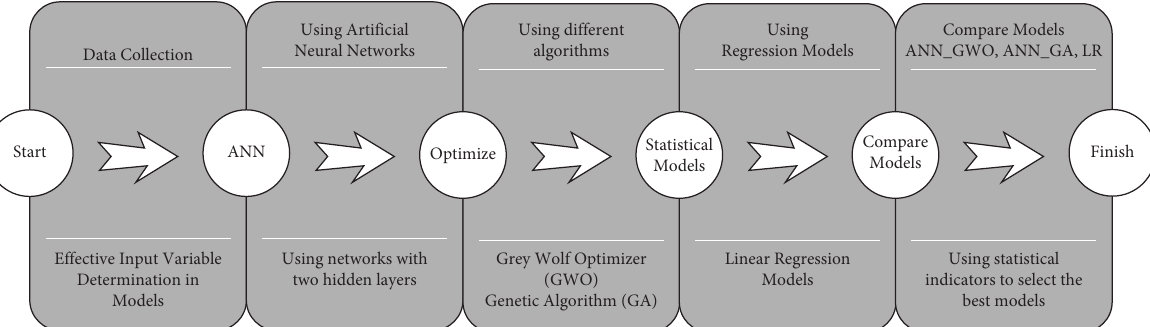
Figure 1: Overview of the research.